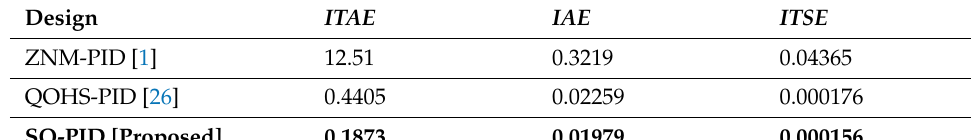
Table 3. Proposed PID output matched for 0.01 p.u. step change in wind speed. Design